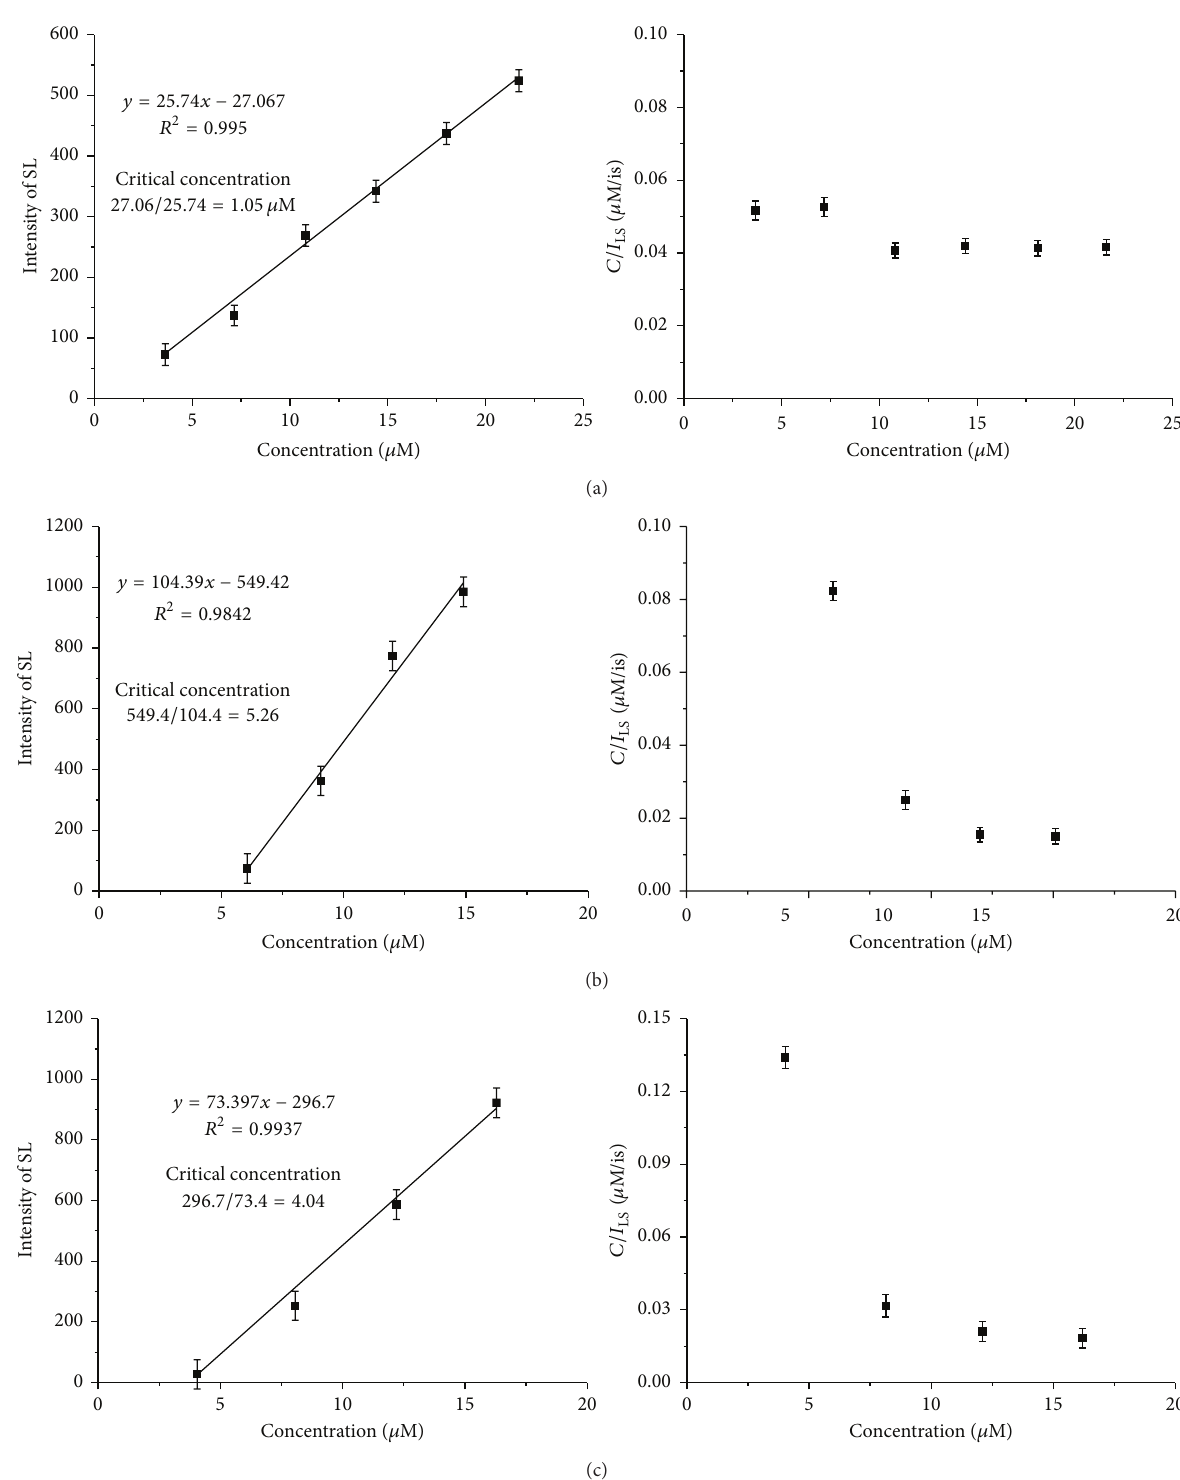
Figure 3: Concentration dependence (left side) and angle dependence (right side) of scattering light of (a) R3 (b) 4RMBD (c) 4RMBD